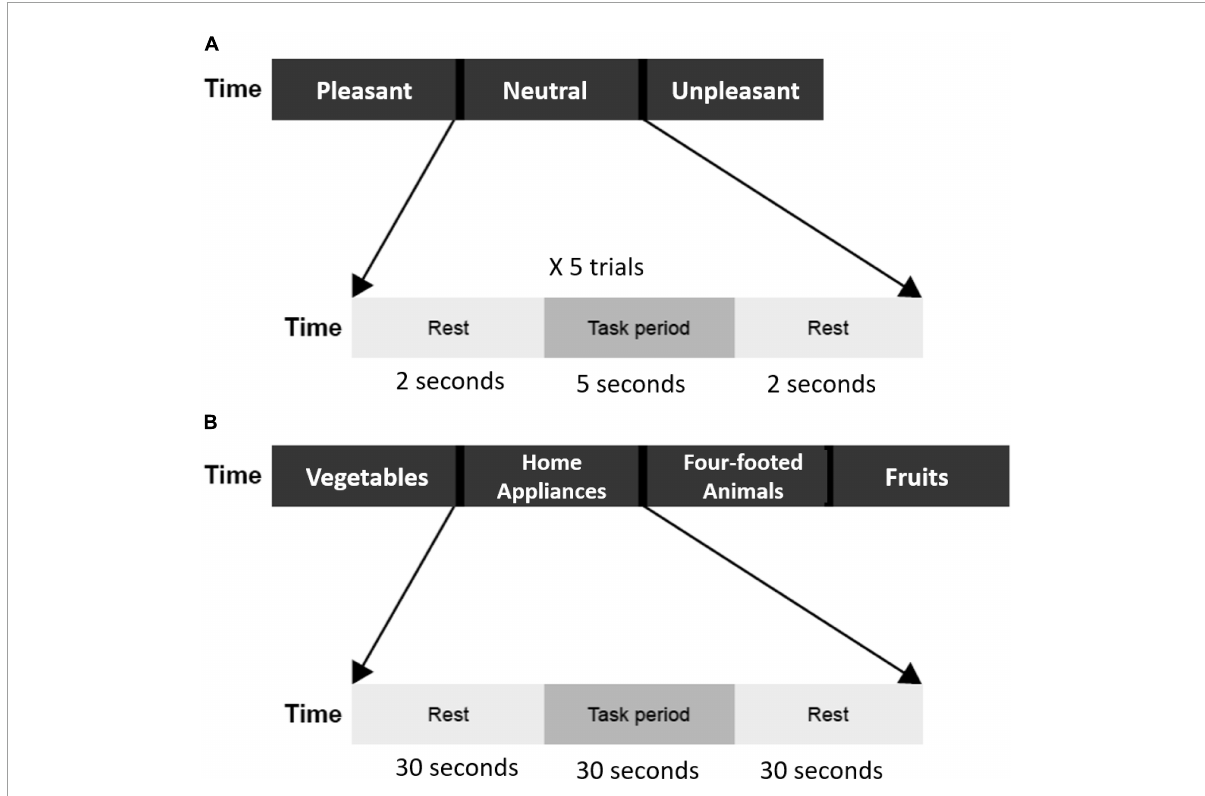
FIGURE1 (A) Flow of emotion induction task. Three emotion blocks (pleasant, neutral unpleasant). Each block includes five trials, and each trial contains a 5-s task period and a 2-s rest period. The total duration of the emotion induction task was 105 s. (B) The flow of verbal fluency task. Four category blocks (vegetables, home appliances, four-footed animals, and fruits). Each block contains a 30-s task period and a 30-s rest period. The total duration of the verbal fluency task was 240